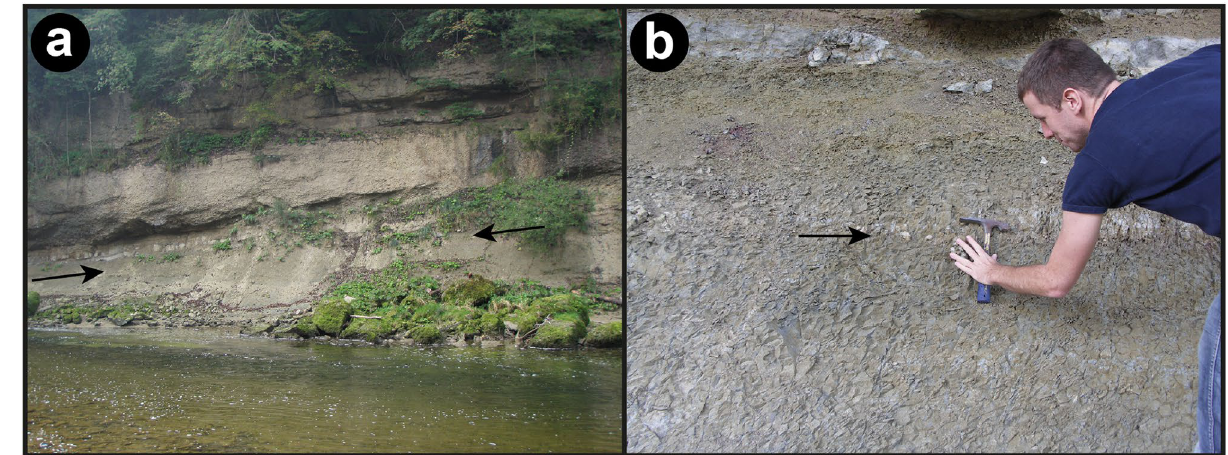
Figure 3. Photographs from the Blockhorizont sampling site near Bernhardzell. ( a ) depicts the Molasse section containing the Blockhorizont (marked with arrows). ( b ) Close-up of the section, with the Blockhorizont marked with an arrow (photograph by Rainer